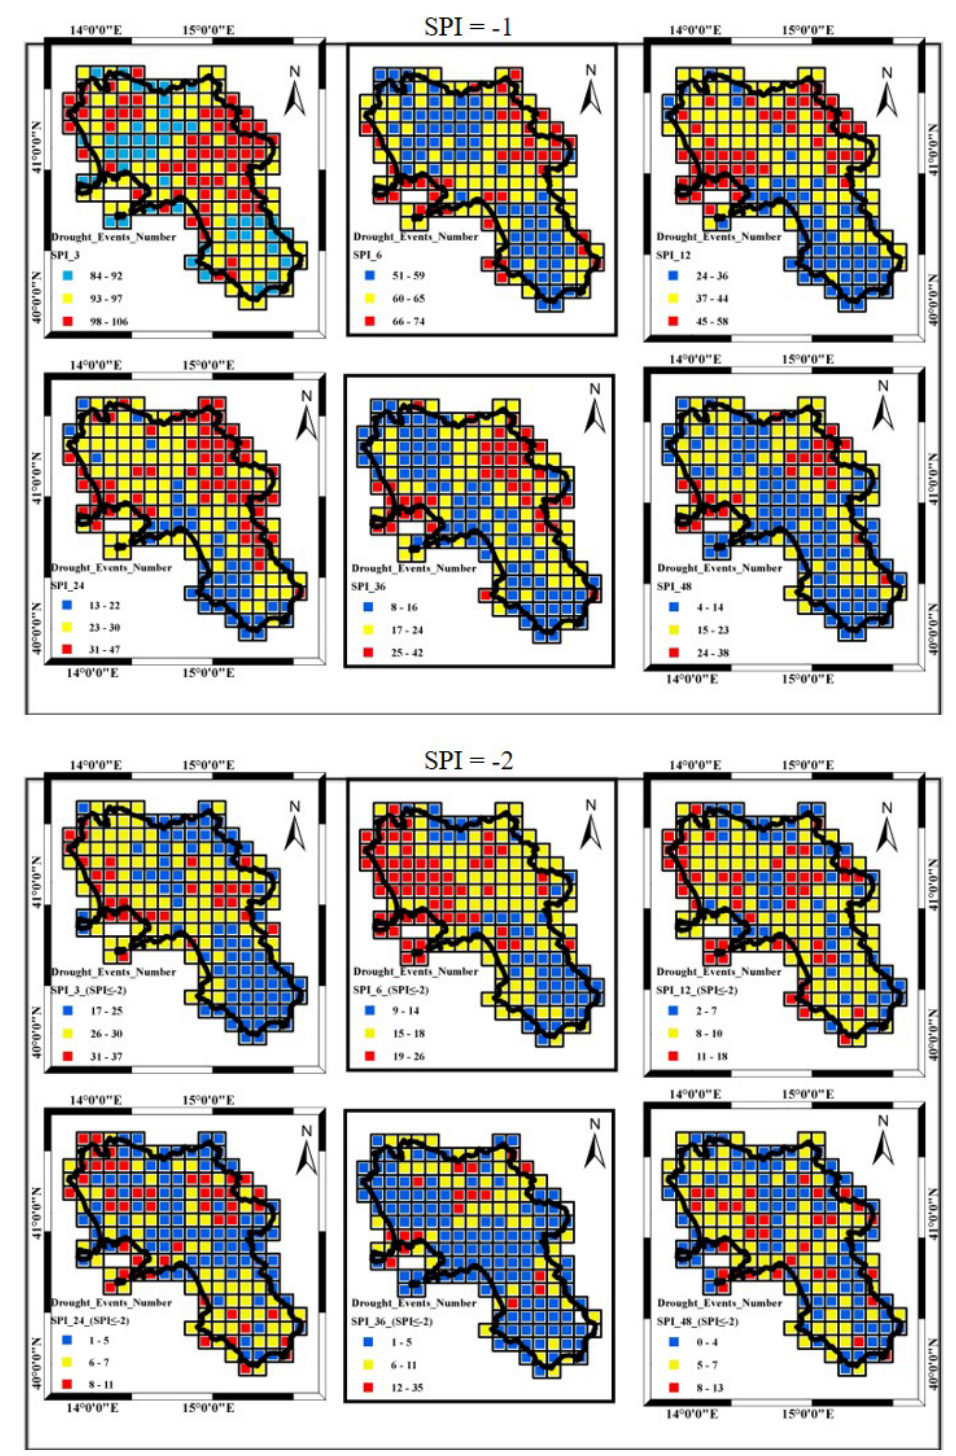
Figure 7. Number of drought events for the different accumulation timescales over the whole period of observation 1918–2019. Upper panels: moderate drought events (SPI ≤ − 1). Lower panels: extremely severe drought events (SPI ≤ −